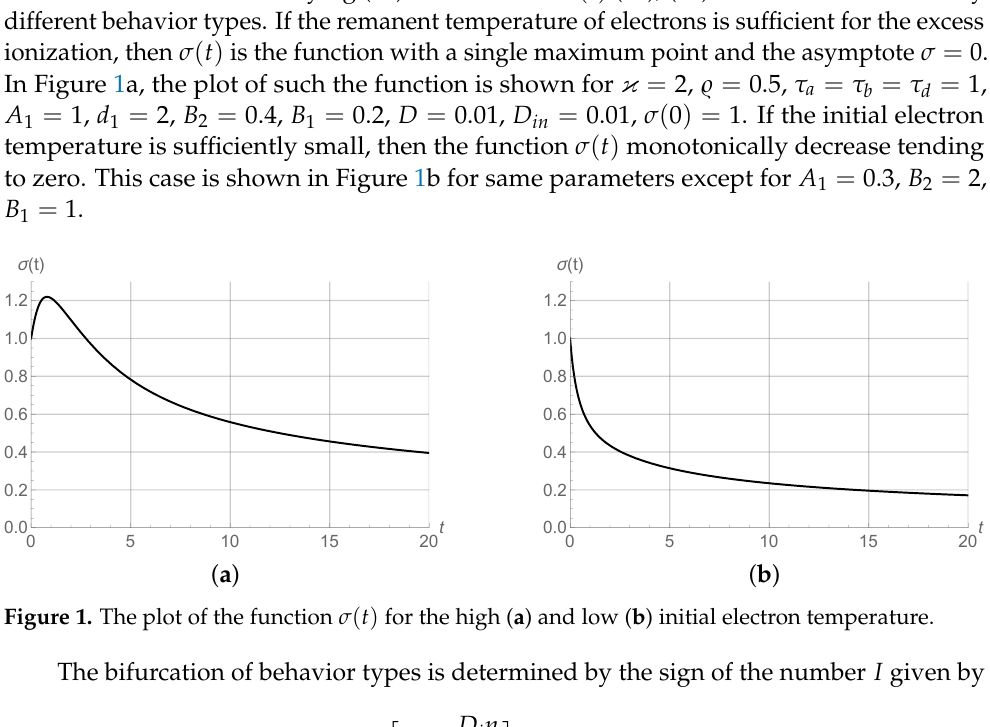
Thus, the condition I > 0 ensures the presence of the excess